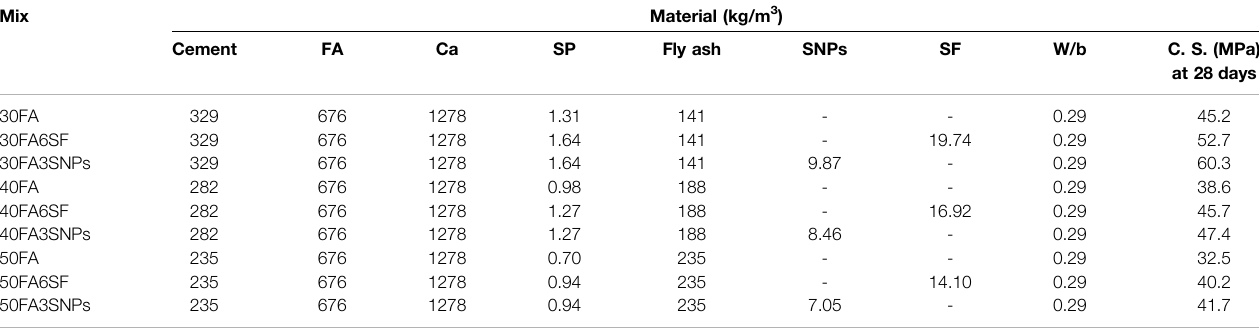
TABLE 2 | M60 mix proportion for fl y ash concrete mixes.